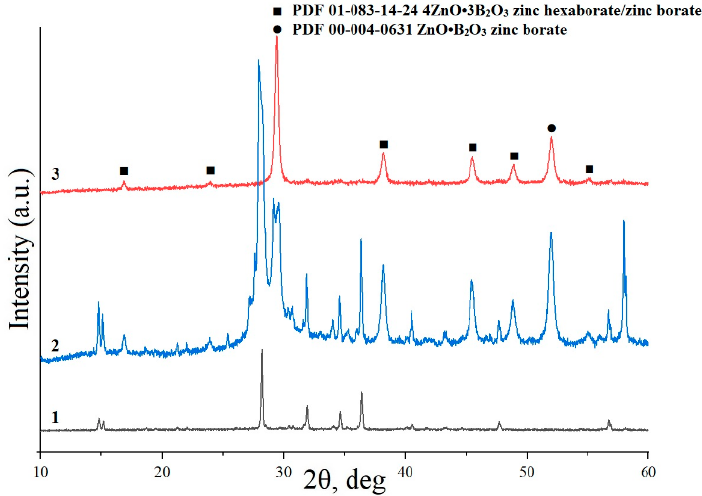
Figure 5. X-ray powder diffraction patterns of samples 3 (curve 3), 4 (curve 2), and 5 (curve 3).